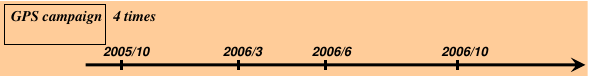
Figure 7. Time schedule for GPS campaigns Fig. 7. Time schedule for GPS campaigns.